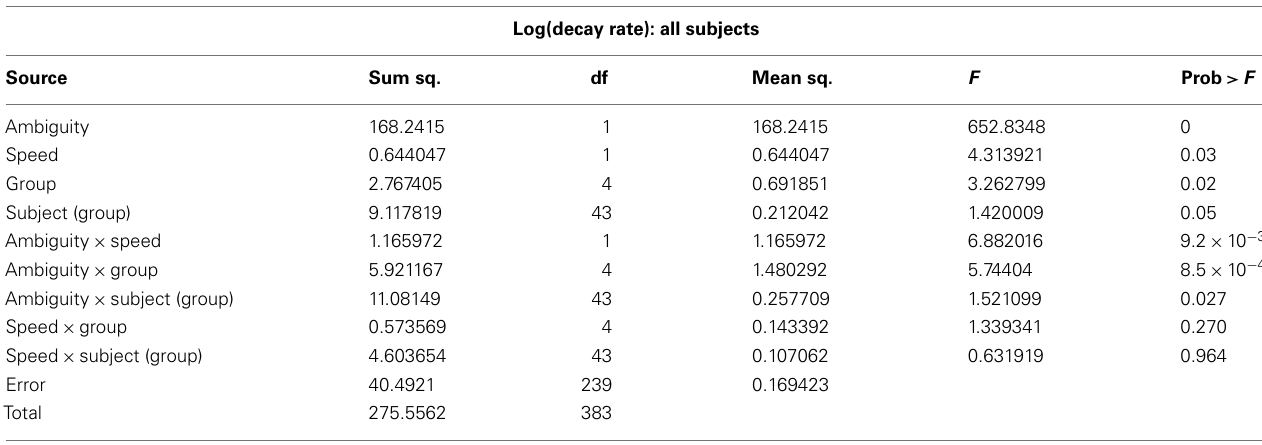
Table 5 | Mixed-model analysis of variance (ANOVA) table to assess different effects on overall log(decay rate) in all subjects